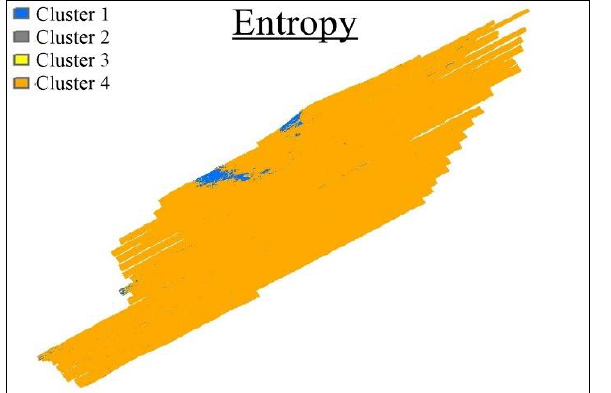
Figure 5: GLCM Entropy Cluster Map